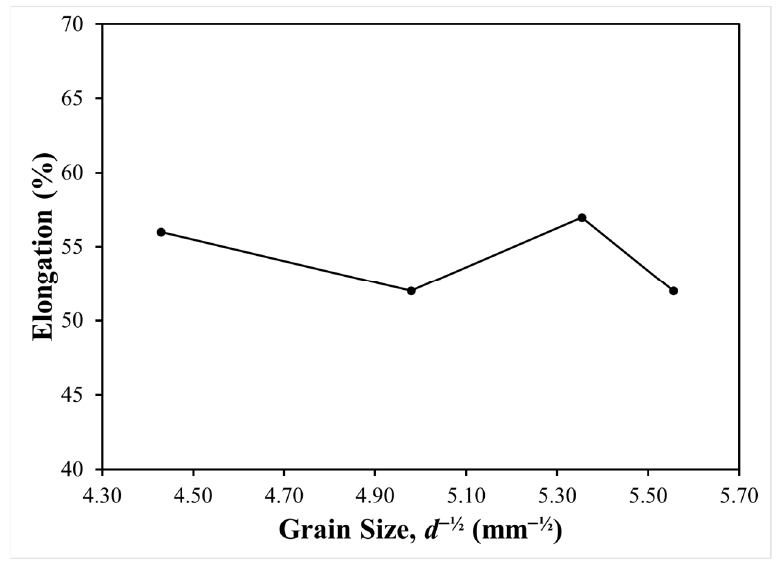
Figure 9. Effect of grain size on elongation.